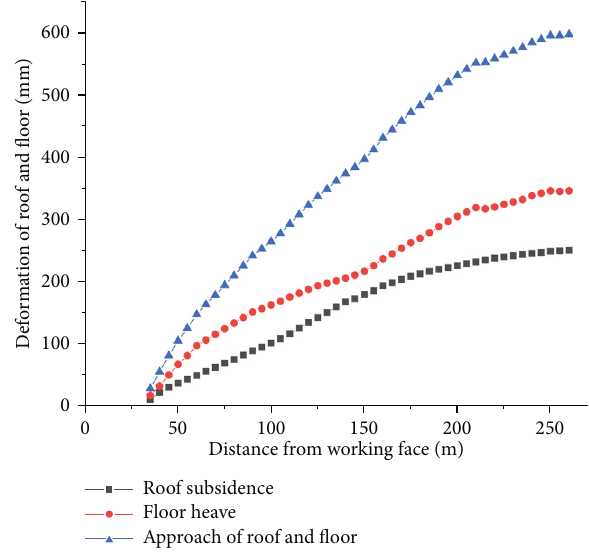
Figure 11: Curve of the roof and fl oor deformation of 24207 gob- side entry retaining.